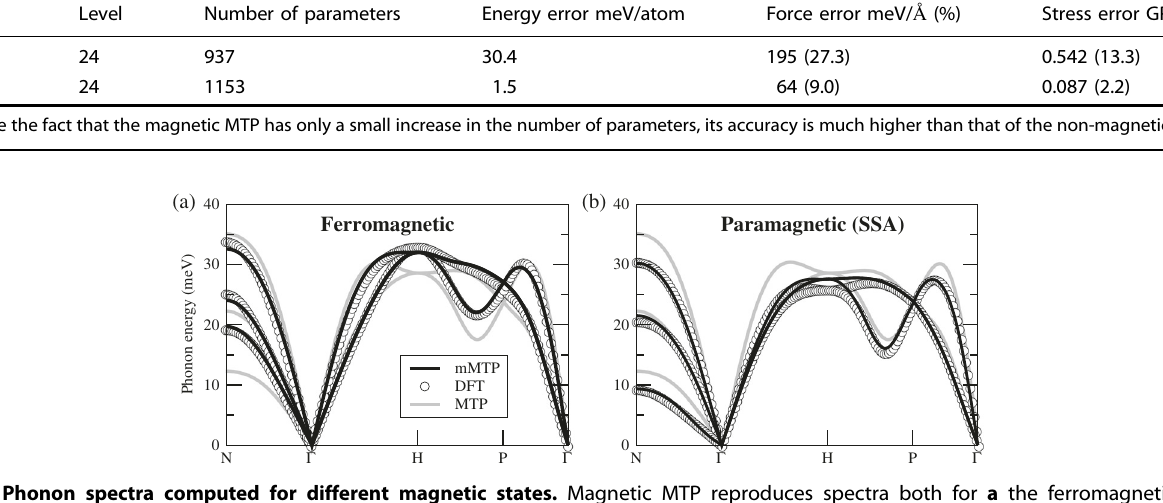
Fig. 2 Phonon spectra computed for different magnetic states. Magnetic MTP reproduces spectra both for a the ferromagnetic and b paramagnetic state (modeled using the SSA approach) based on the DFT calculations, whereas non-magnetic MTP cannot distinguish the two states and produces results between the ferromagnetic and paramagnetic